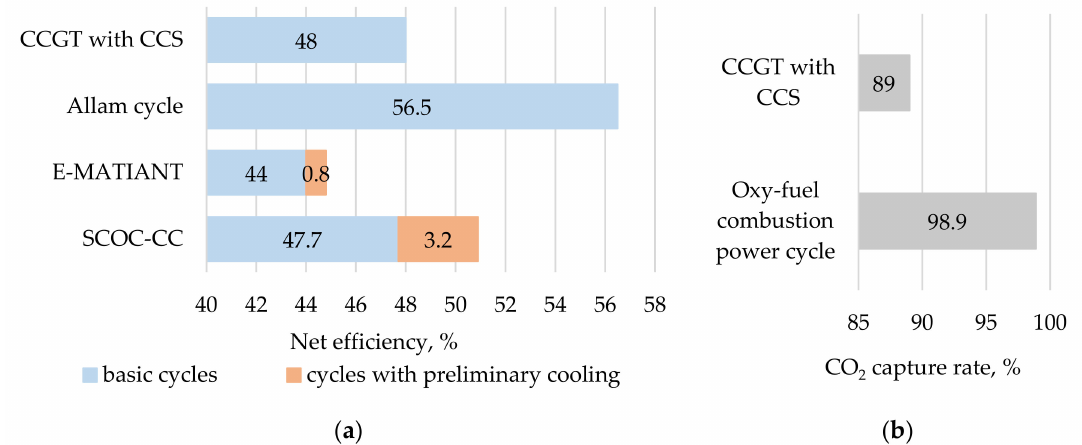
Figure 16. Thermal efficiency and environmental performance of oxy-fuel combustion power cycles and combined cycles with CO 2 storage cycles: ( a ) technology efficiency; ( b ) technology environmental